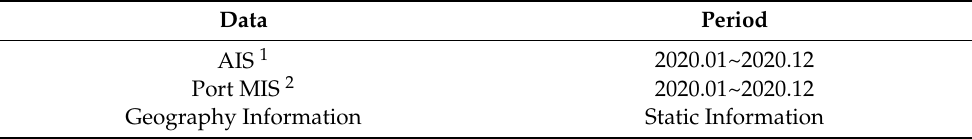
Table 1. Input data for the forecast algorithm.